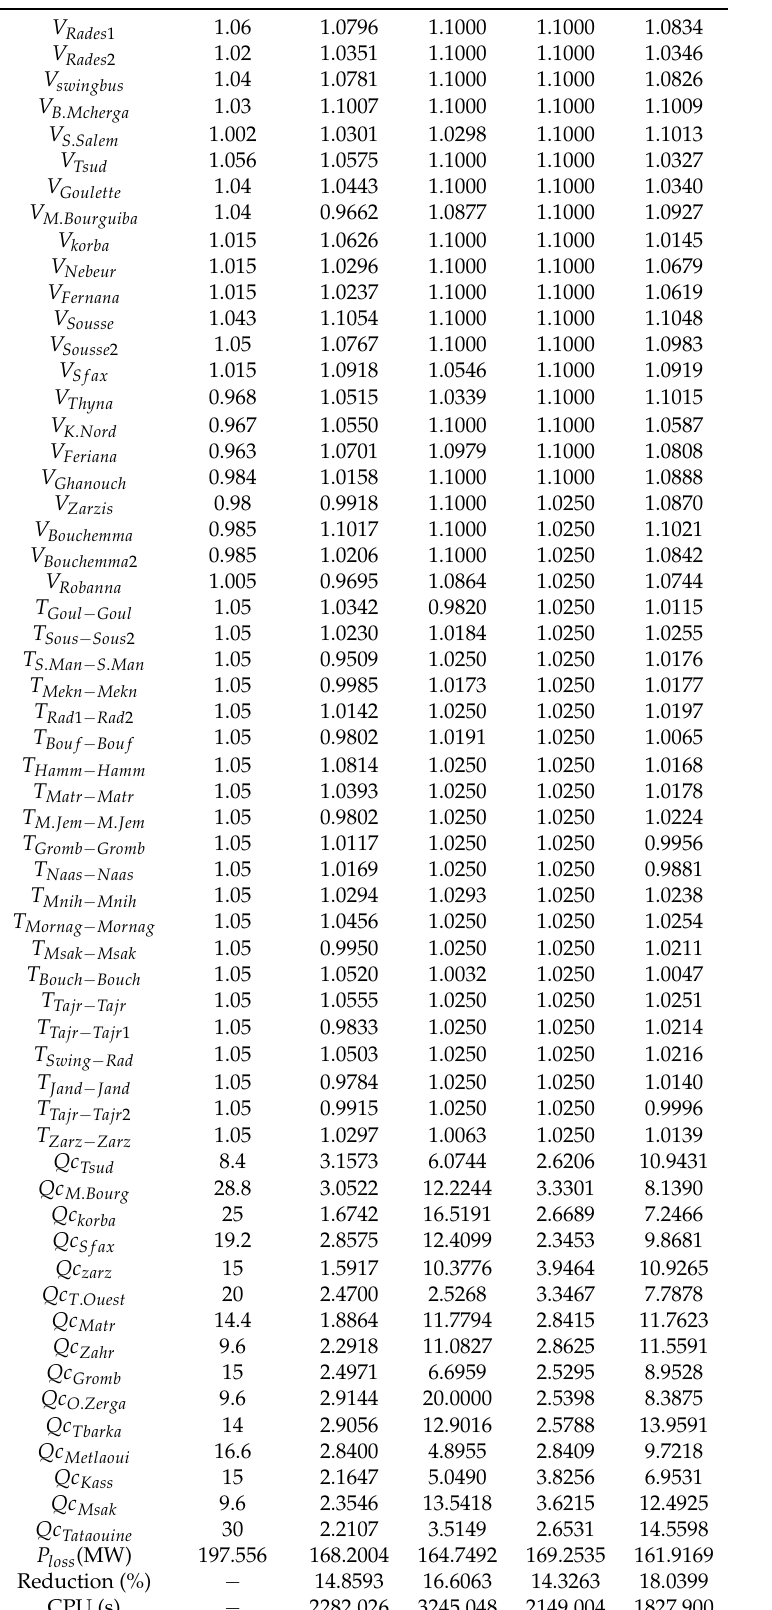
Table 5. Comparison of simulation results for Tunisian 86-bus system using various